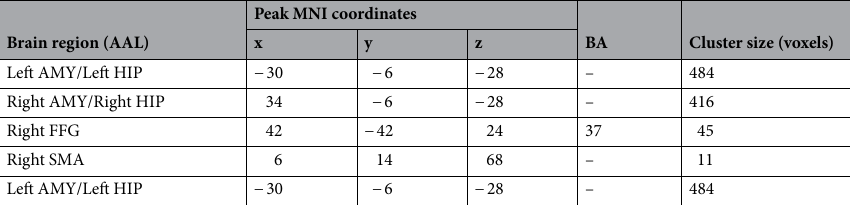
Table 2. ROIs related to facial emotions. All brain regions are thresholded at p < 0.01, FDR corrected, with a minimum cluster size of 10 voxels. MNI coordinates of ROIs are reported here. AAL, Anatomical Automatic Labeling; MNI, Montreal Neurological Institute; BA, Brodmann area; AMY, amygdala; HIP, hippocampus; FFG, fusiform gyrus; SMA, supplementary motor area.